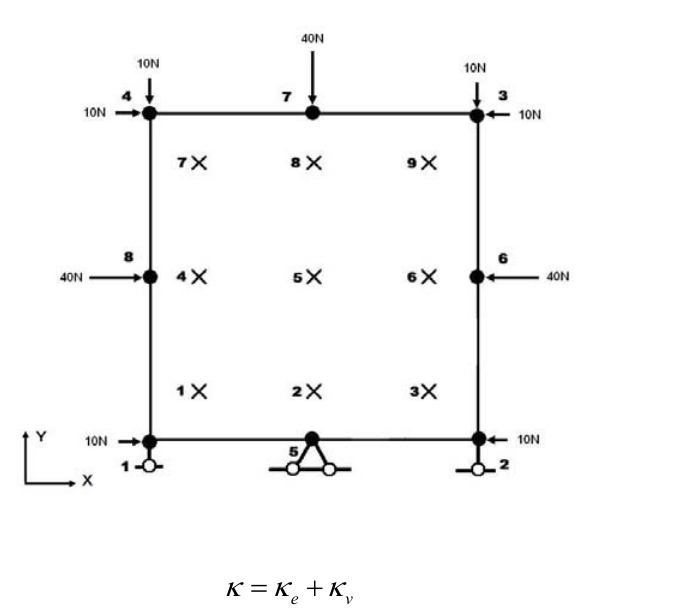
Figure 4. Plane strain element under compressive